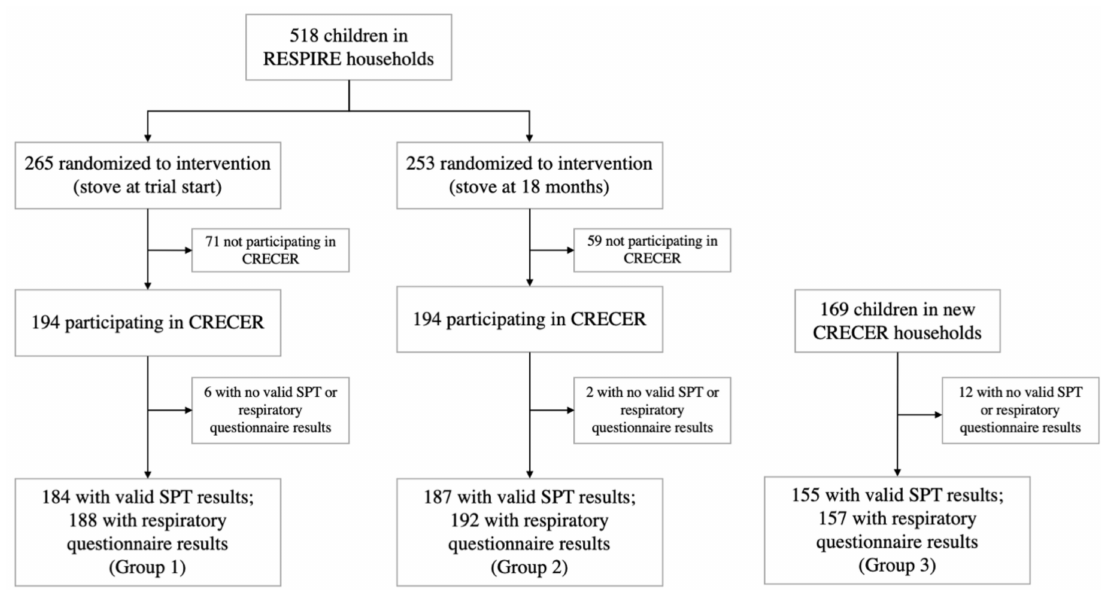
Figure 1. Study diagram and timeline for the Randomized Exposure Study of Pollution Indoors and Respiratory Effects (RESPIRE) and the Chronic Respiratory Effects of Early Childhood Exposure to Respirable PM cohort study